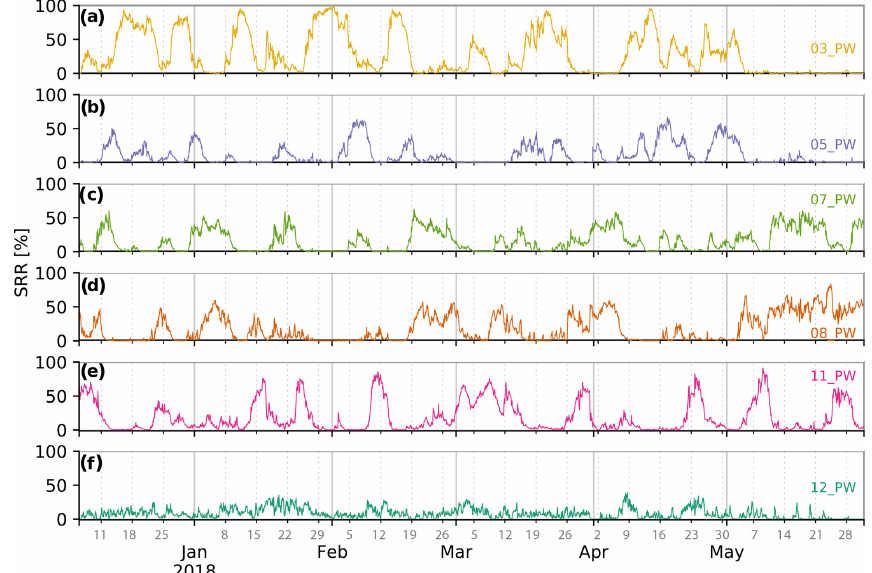
Figure 8. Time series of the SRR [%] influence for each of the six main PWs from 6 December 2017 until 31 May